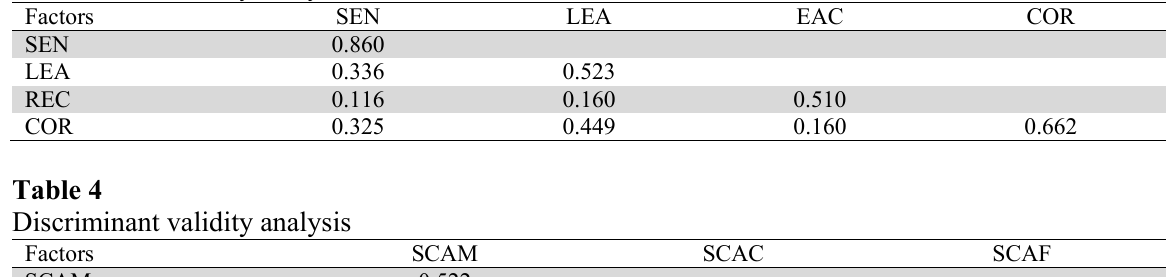
Discriminant validity analysis